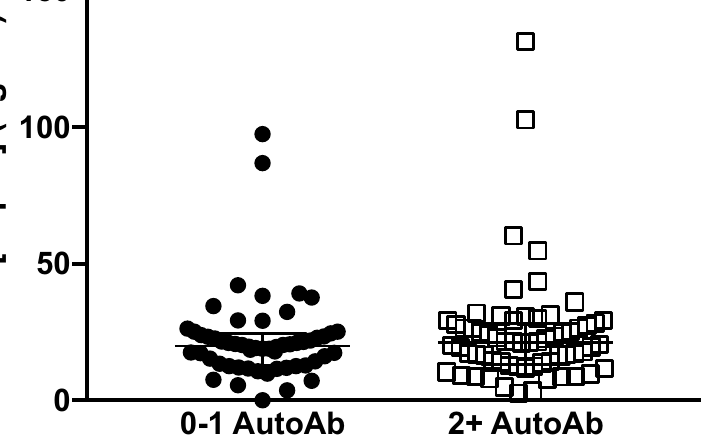
Fig 3. Relationship of serum Hsp90 levels with islet autoimmunity. Scatterplot comparing serum Hsp90 levels in subjects testing positive for 0–1 ( n = 56) and two or more ( n = 64) islet autoantibodies (AutoAb). No difference was observed by Mann-Whitney test ( P =